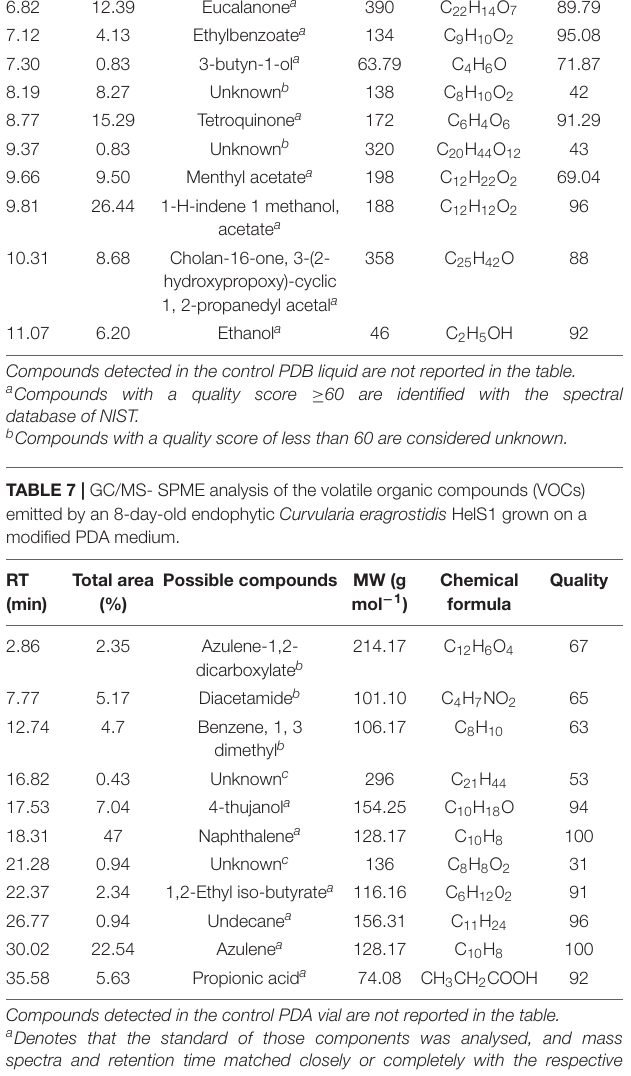
Chemical mol − 1 ) formula